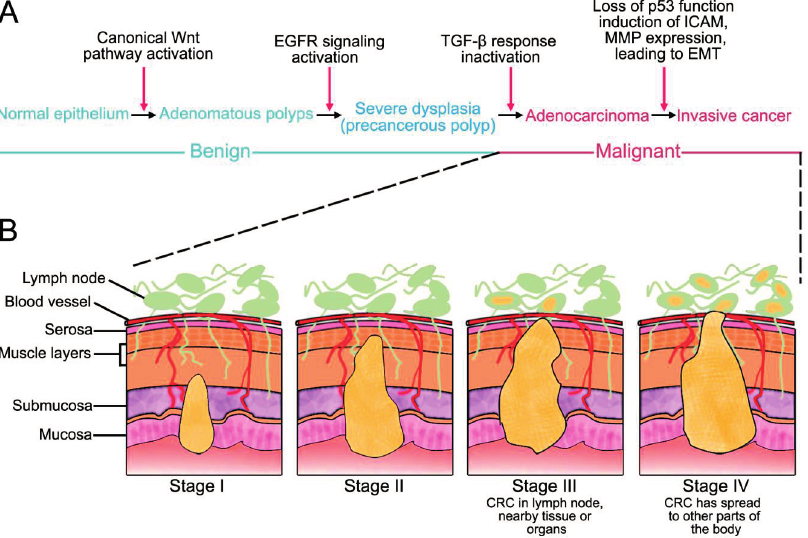
Figure 2. Scheme of colon cancer cells progression. ( A ) The progression of mutations that commonly lead to colorectal cancer; ( B ) Scheme that represent the four stage of colorectal cancer (CRC): Stage I–IV: Note that CRC in Stage IV is in lymph node and has spread to at least one distant